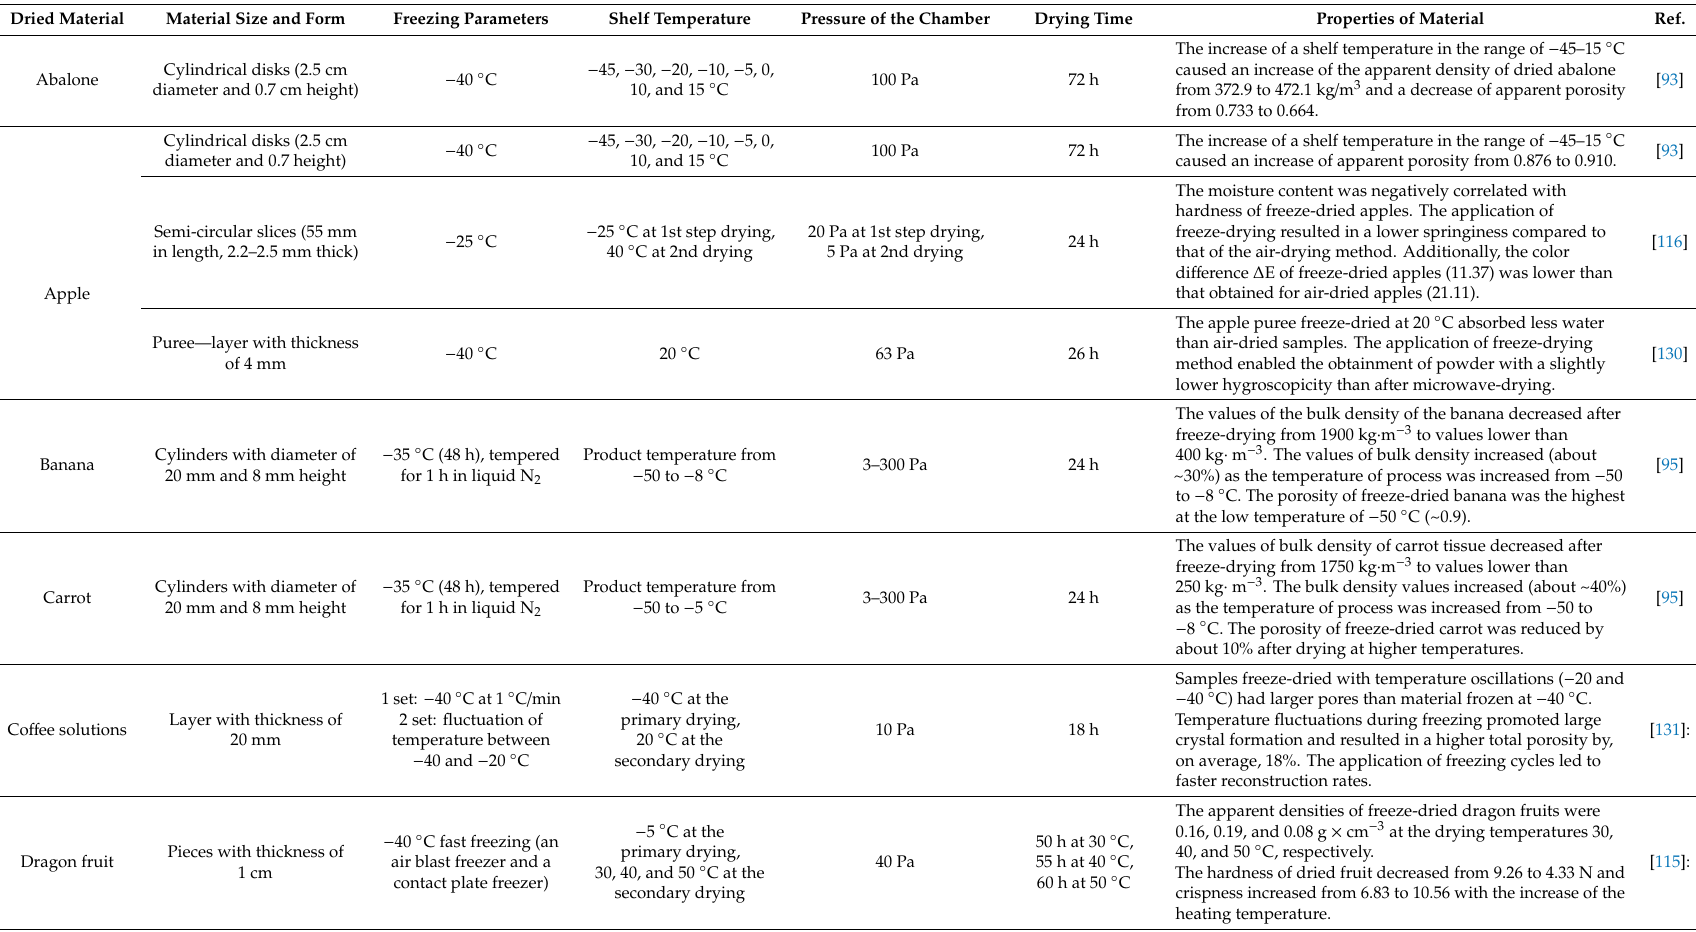
Table 2. Parameters of lyophilization and the properties of selected freeze-dried